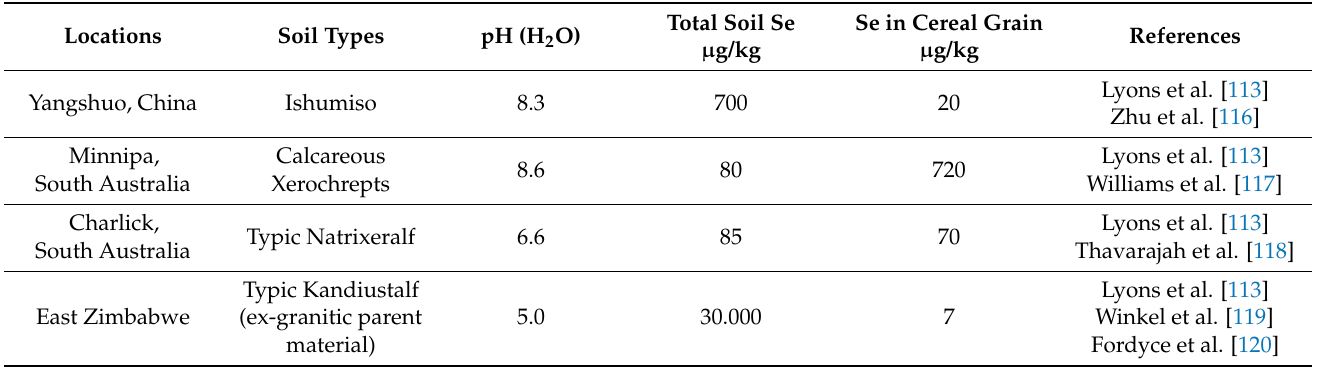
Table 4. Variability in Se concentrations in soils from different locations across the